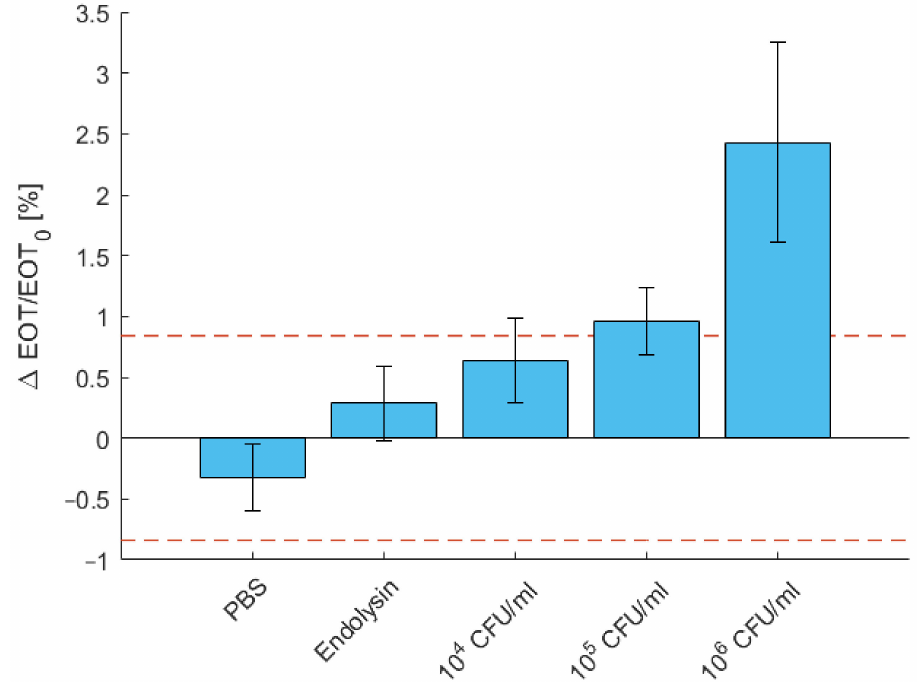
Figure 8. Characteristic relative effective optical thickness (EOT) shift measured on a PSi membrane after 1 h in PBS, in a PlyB221 endolysin suspension and in increasing concentrations of B. cereus lysate ( n ≥ 3). The dashed red line represents the noise level, fixed as 3 σ of the signal measured in PBS. The detection limit is 10 5 CFU/ml of B. cereus